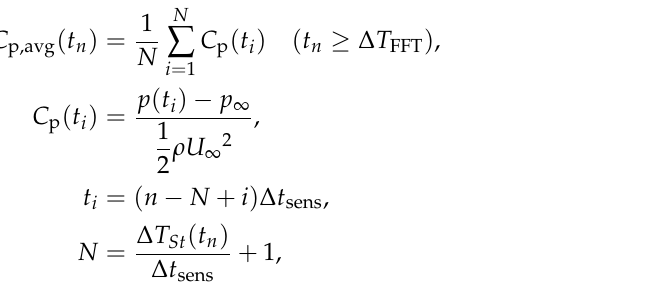
) histogram in each FTM case at α = tmp